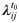
A graphical representation of path λijt0.